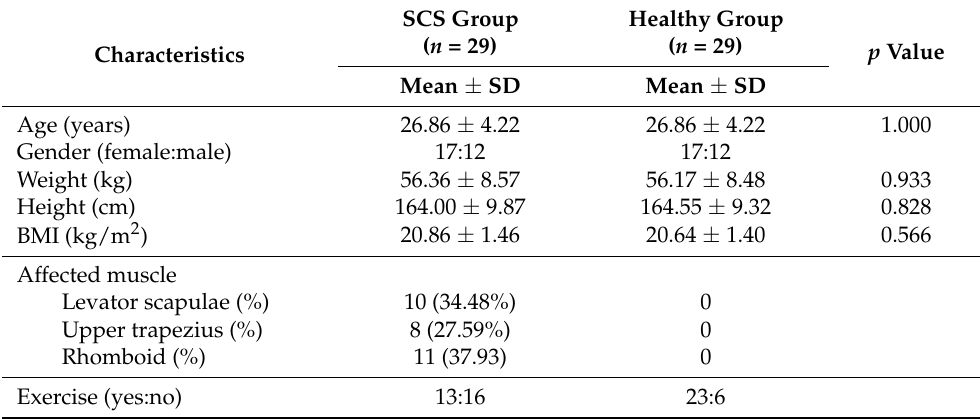
Table 1. Demographic data of the sample population at baseline.